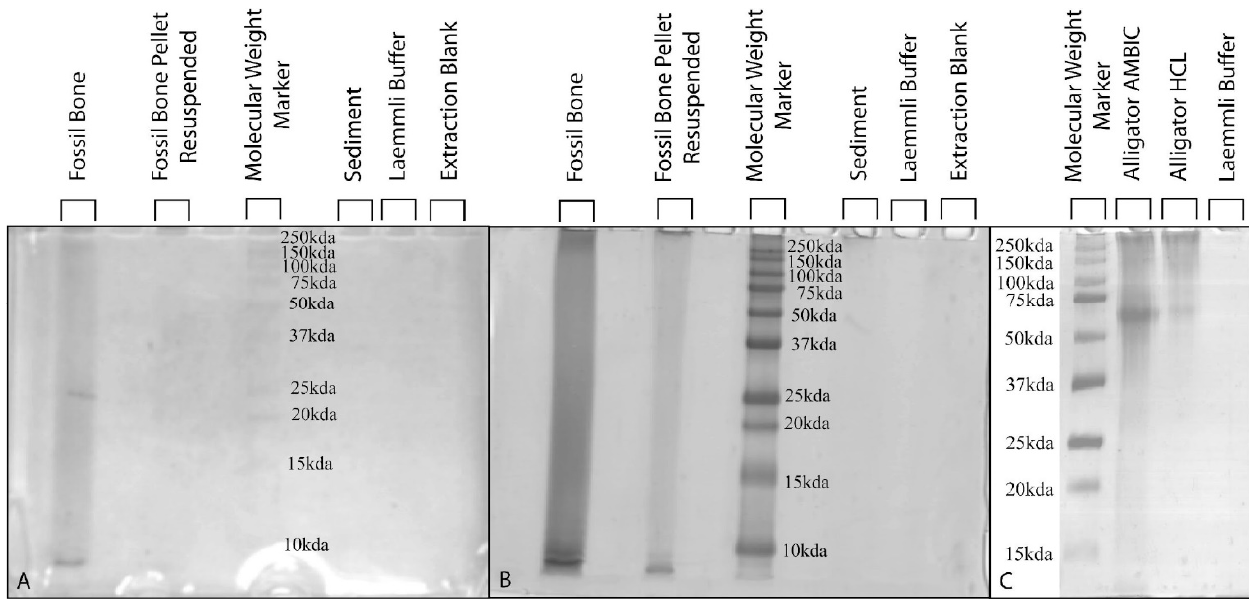
Figure 5. Polyacrylamide gel electrophoresis (PAGE) with silver-staining of fossil and modern samples. ( A ) PAGE of fossil samples prior to silver-staining, exhibiting pre-staining in the fossil bone lane. Fossil samples were loaded at 50mg of pre-extracted bone per lane; ( B ) same gel as ( A ) after development with silver nitrate. Both fossil sample lanes exhibit increased staining, whereas no binding is visible in sediment, Laemmli buffer, and extraction blank lanes; ( C ) silver-staining of modern Alligator samples, loaded at 20 µ